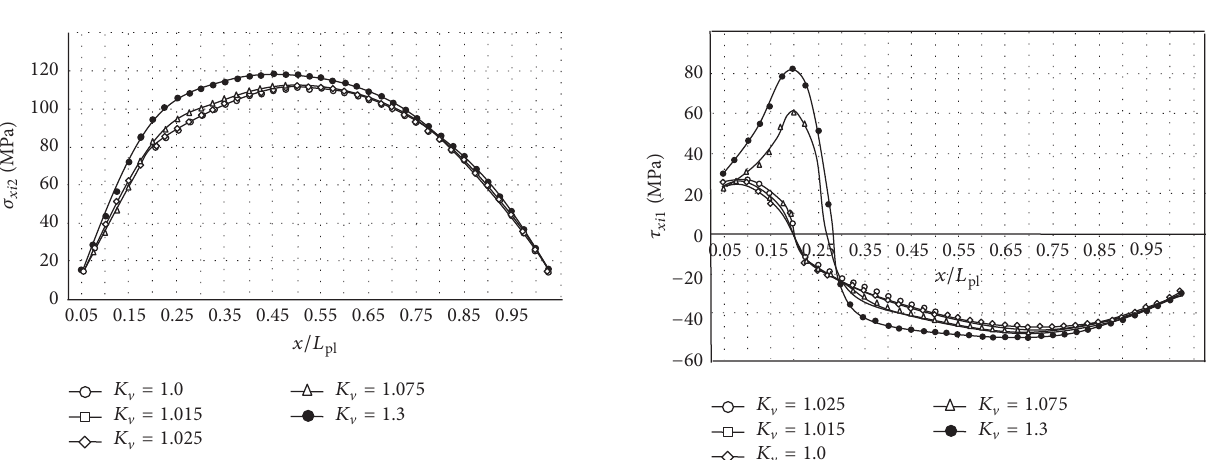
Figure 6: The calculated distributions of tangential contact stresses on the detail along the zone of surfacing, depending on the speed asymmetry coefficient (the initial thickness of the compact material is 0.5 mm).